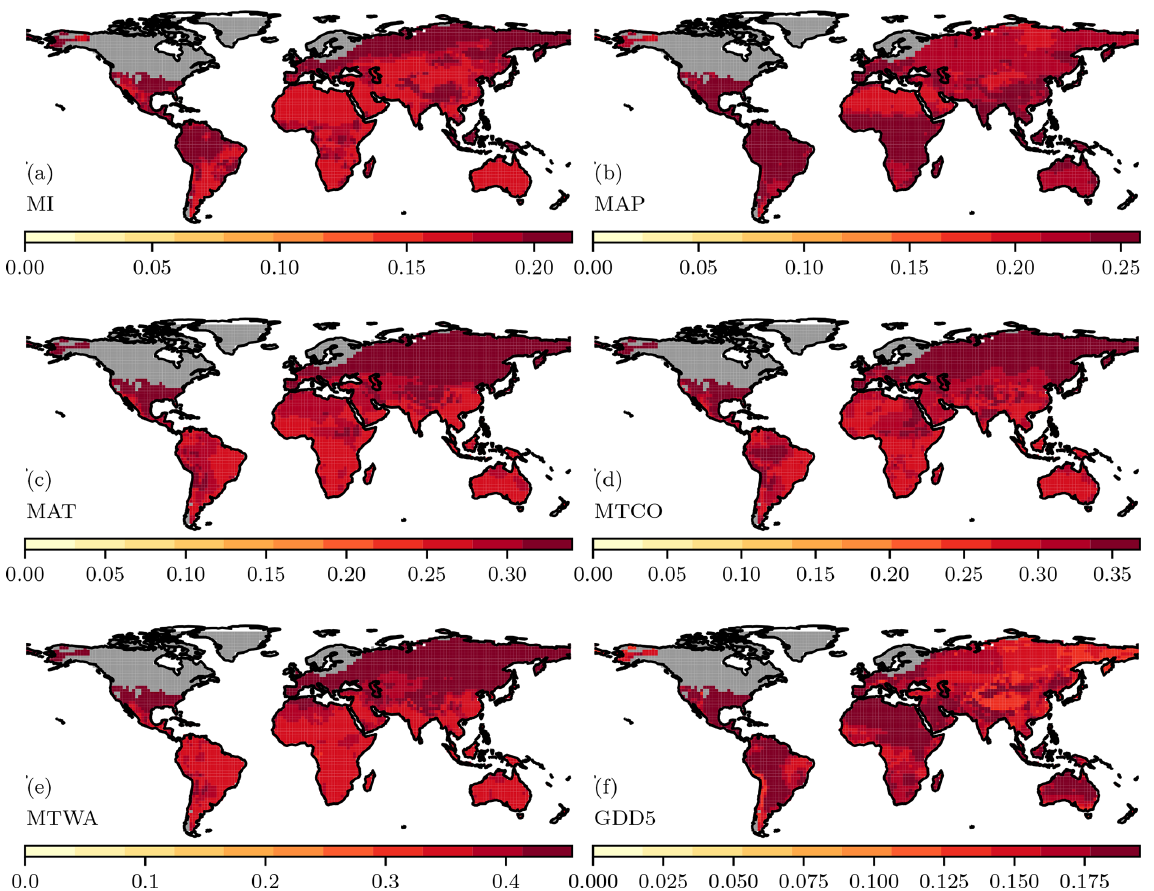
Figure 2. Uncertainties associated with the climate prior. The climate is derived from a multi-model mean of the ensemble of models from the Palaeoclimate Modelling Intercomparison Project (PMIP) and is shown in Fig. S1 in the Supplement. The uncertainties shown here are the standard deviation of the multi-model ensemble values. The individual plots show the variance for the simulated (a) moisture index (MI), (b) mean annual precipitation (MAP), (c) mean annual temperature (MAT), (d) mean temperature of the coldest month (MTCO), (e) mean temperature of the warmest month (MTWA), and (f) growing degree days above a baseline of 5 ◦ C